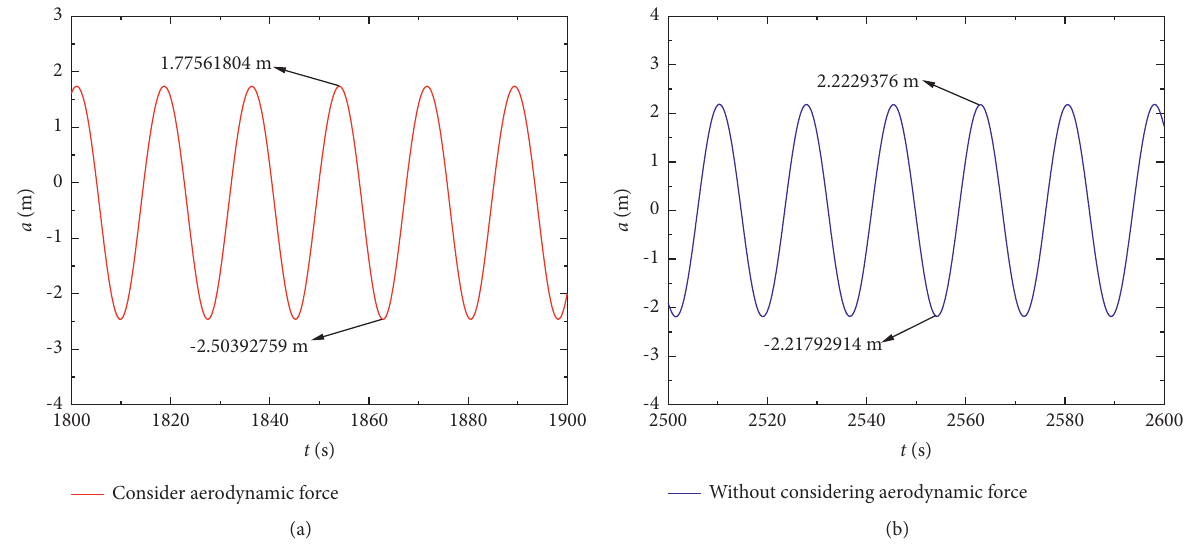
Figure 6: The displacement time history curve of primary resonance (a) without considering aerodynamic force and (b) considering aerodynamic force.